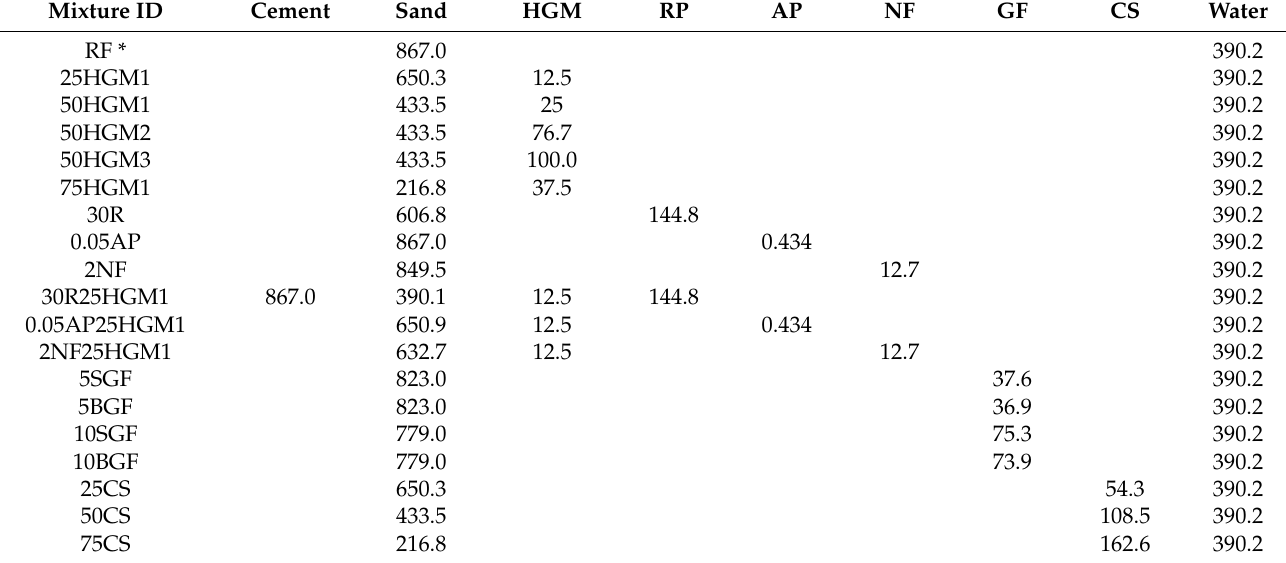
Table 3. Mix proportions for specimens (kg/m 3